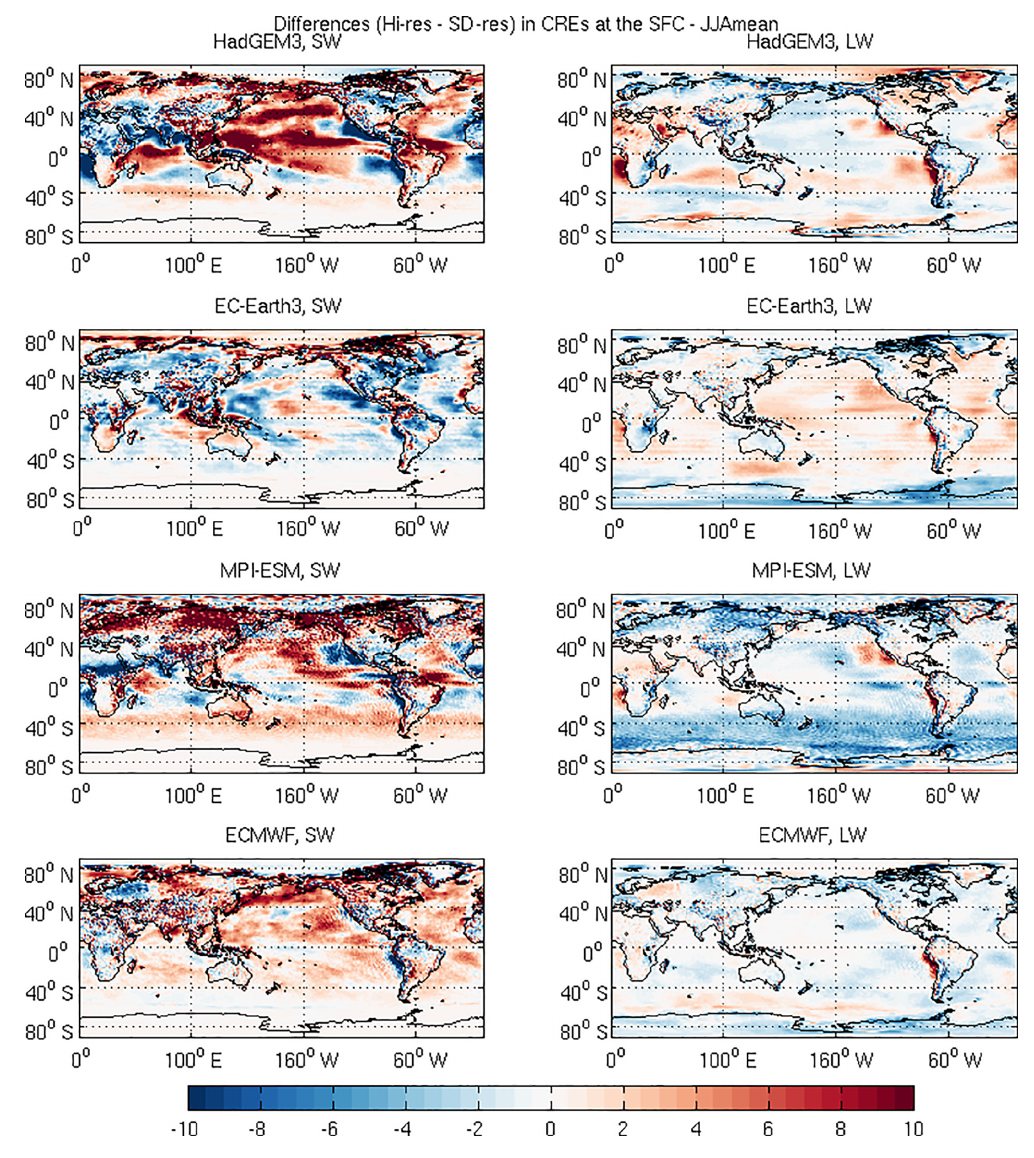
Figure A2. Same as Fig. A1 but during